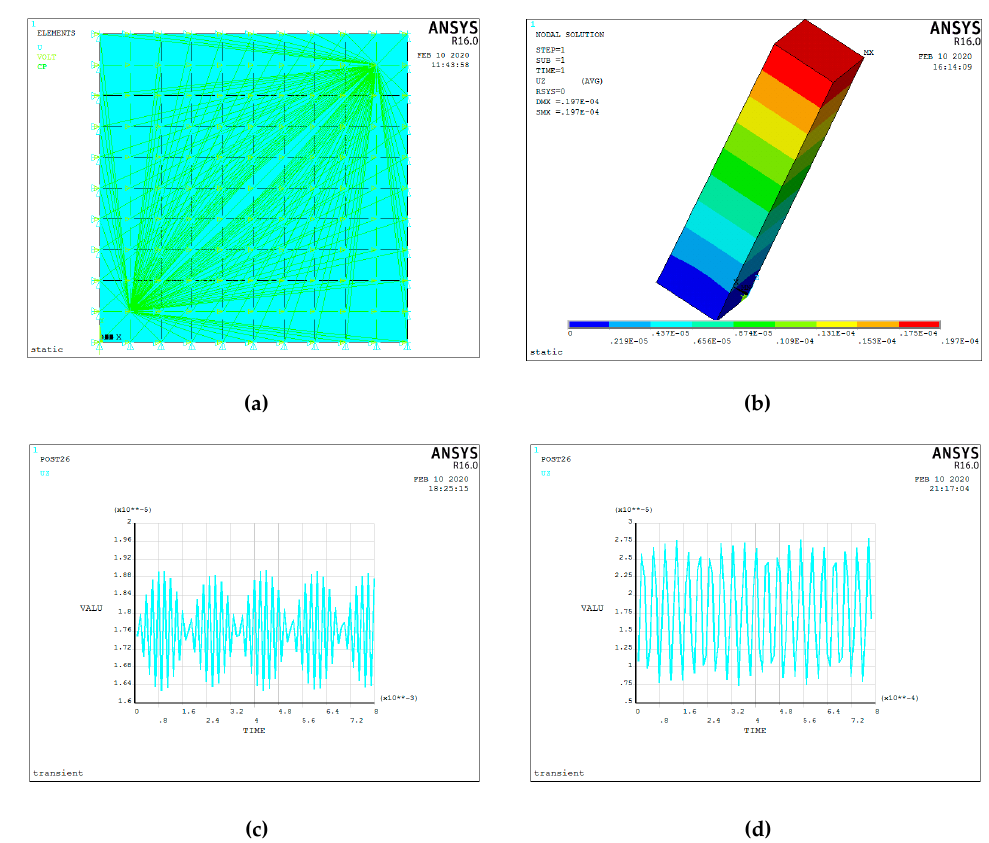
Figure 19. Finite element analysis results of piezoelectric actuator. ( a ) Voltage load applied on the piezoelectric actuator; ( b ) deformation displacement of the piezoelectric actuator; ( c ) transient response at 1000 Hz of the exciting frequency; ( d ) transient response at 5713 Hz of the exciting frequency.